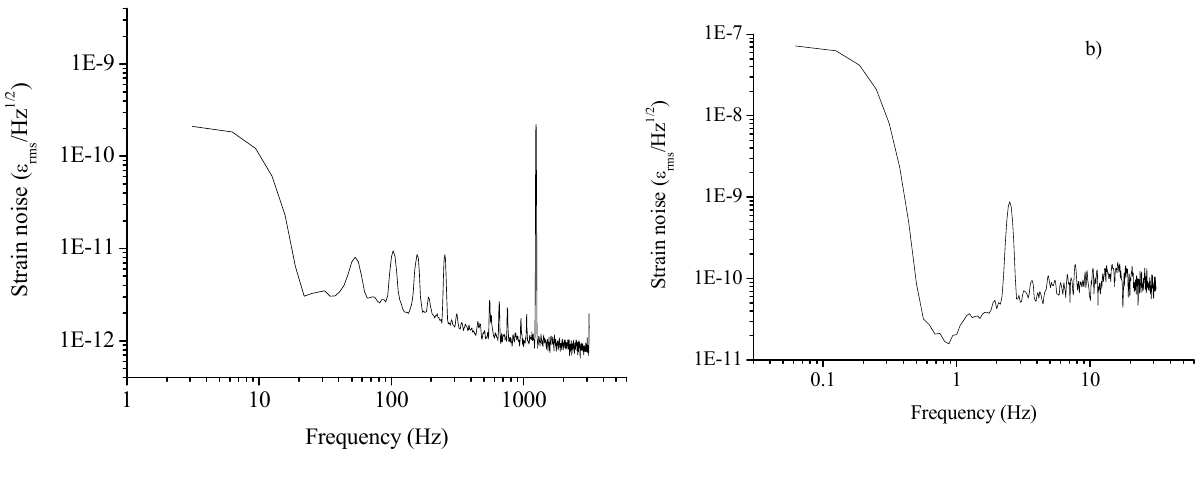
Figure 7. Noise spectral density of the FBG-resonator locking signal for different excitation frequencies in the SM-fiber cavity: (a) a sharp peak is evident at 1.2 kHz with a noise increase towards low frequencies and spurious oscillations due to harmonics of the AC line frequency; (b) the system is capable of detecting deformations down to 2.4